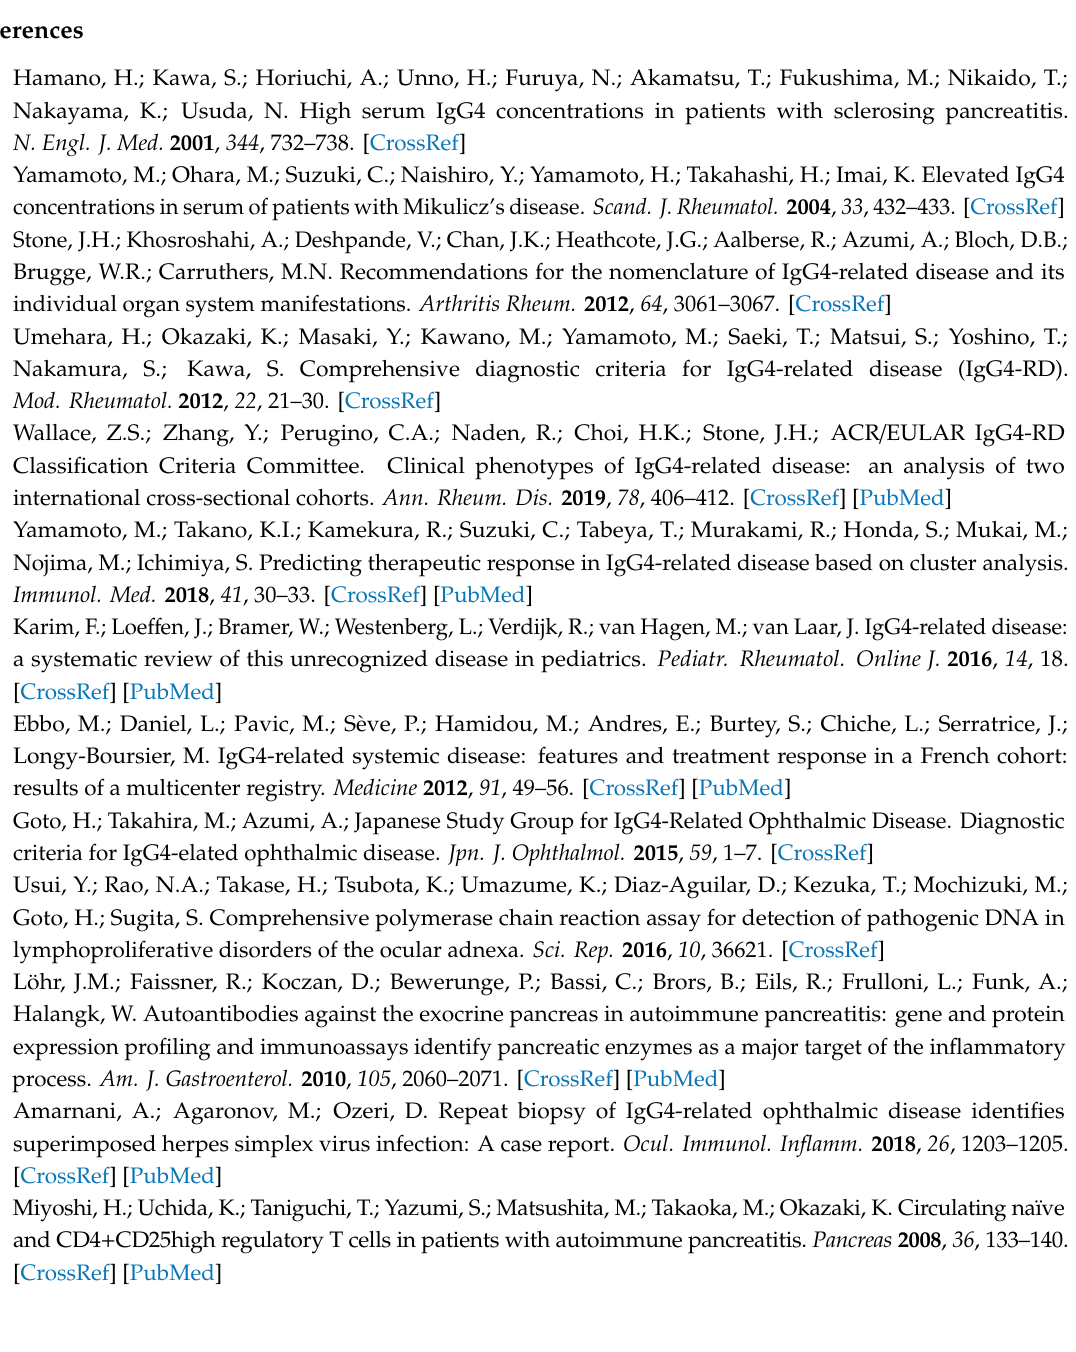
Figure S1: The patients clustered into four groups by condensed unbiased clustering analysis using 10 peripheral blood findings; Table S1: Clinical findings in four groups classified according to new clustering